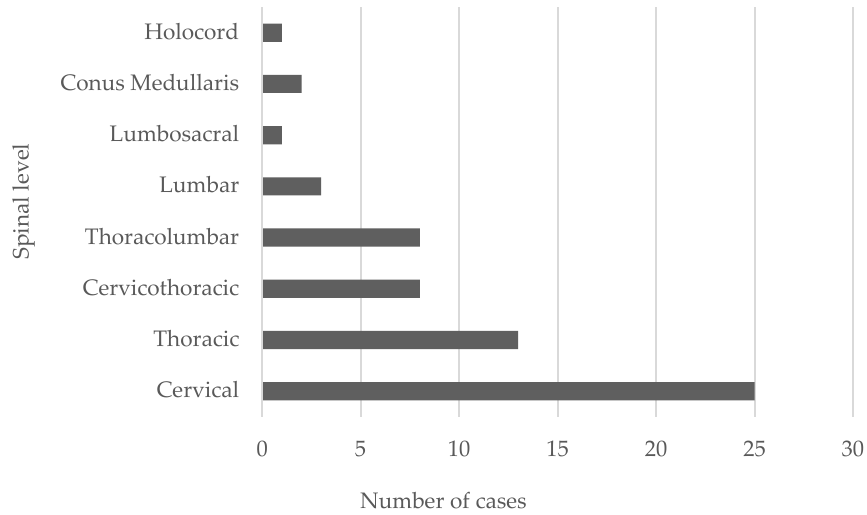
Figure 6. The typical localization of spinal cord abscess in 61 patients with intramedullary spinal cord abscess.